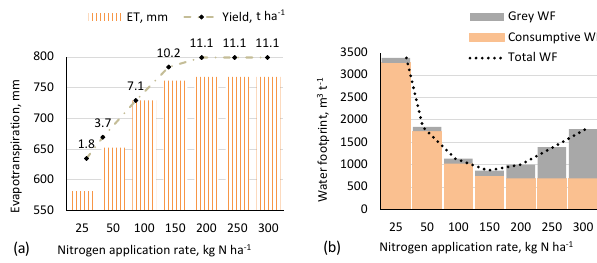
Figure 5. Evapotranspiration and yield (a) and consumptive WF and grey WF per tonne (b) for the reference management